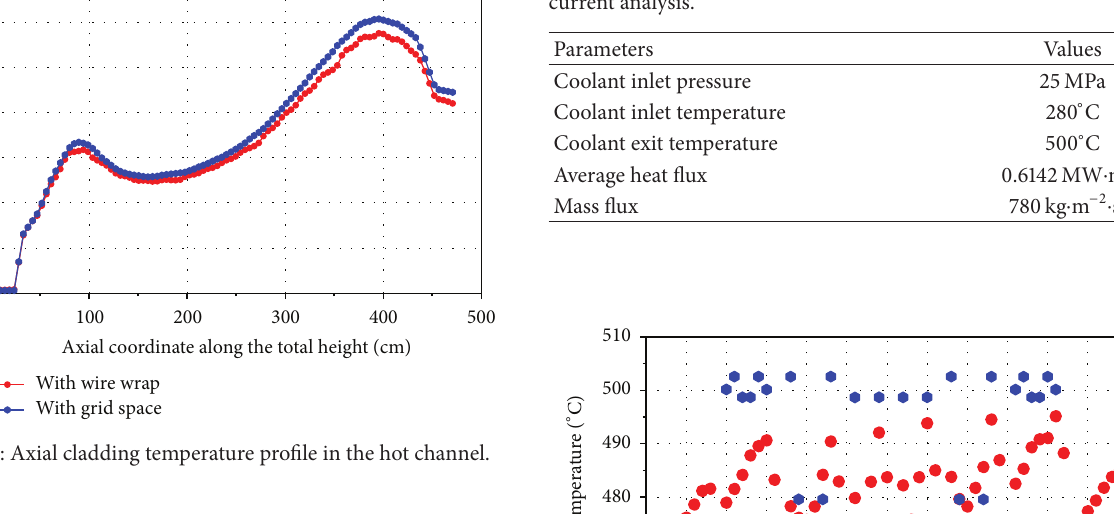
Table 1: Fuel assembly geometry parameters.